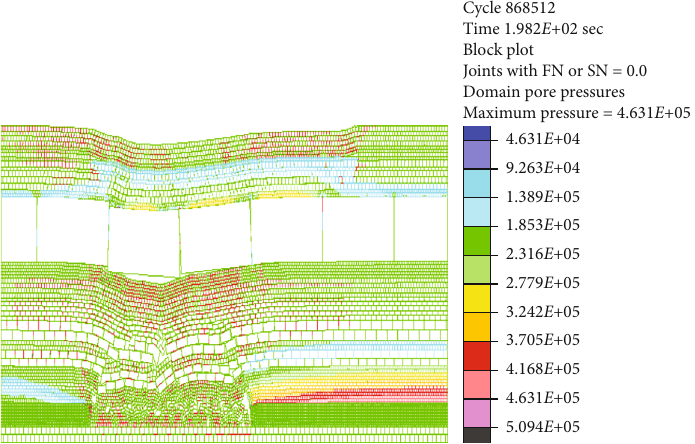
Figure 12: The pore pressure distribution in initial caving of key layer 3.